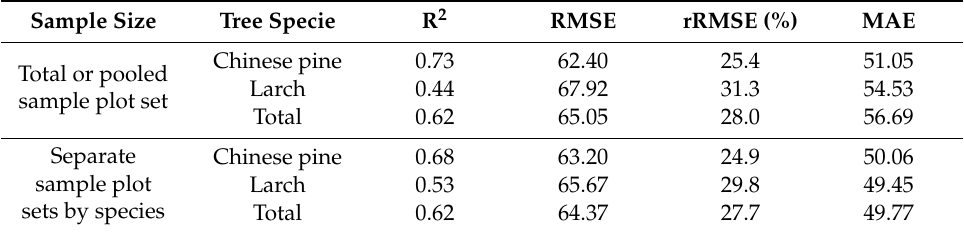
Table 10. Feature variable results based on SRF method under two tree species (m 3 / ha). Sample